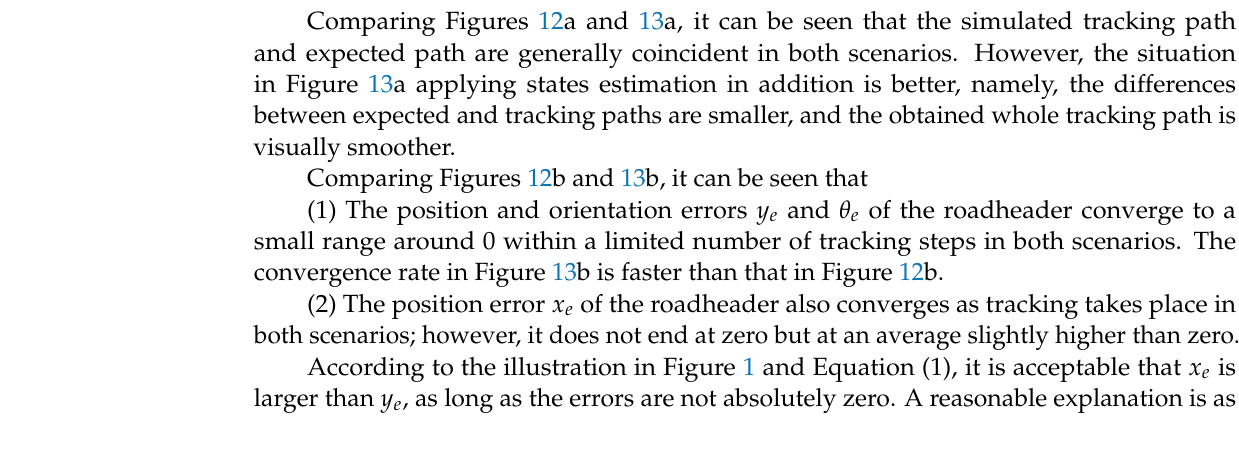
Figure 12. Path tracking through BP neural network for coefficient optimization but without using states estimation: ( a ) the coincidence between expected and simulated tracking paths; ( b ) the position and orientation errors; ( c ) the required angular speeds of the driving